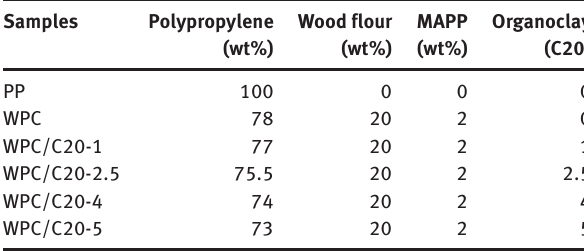
Table 1: The composition of designed